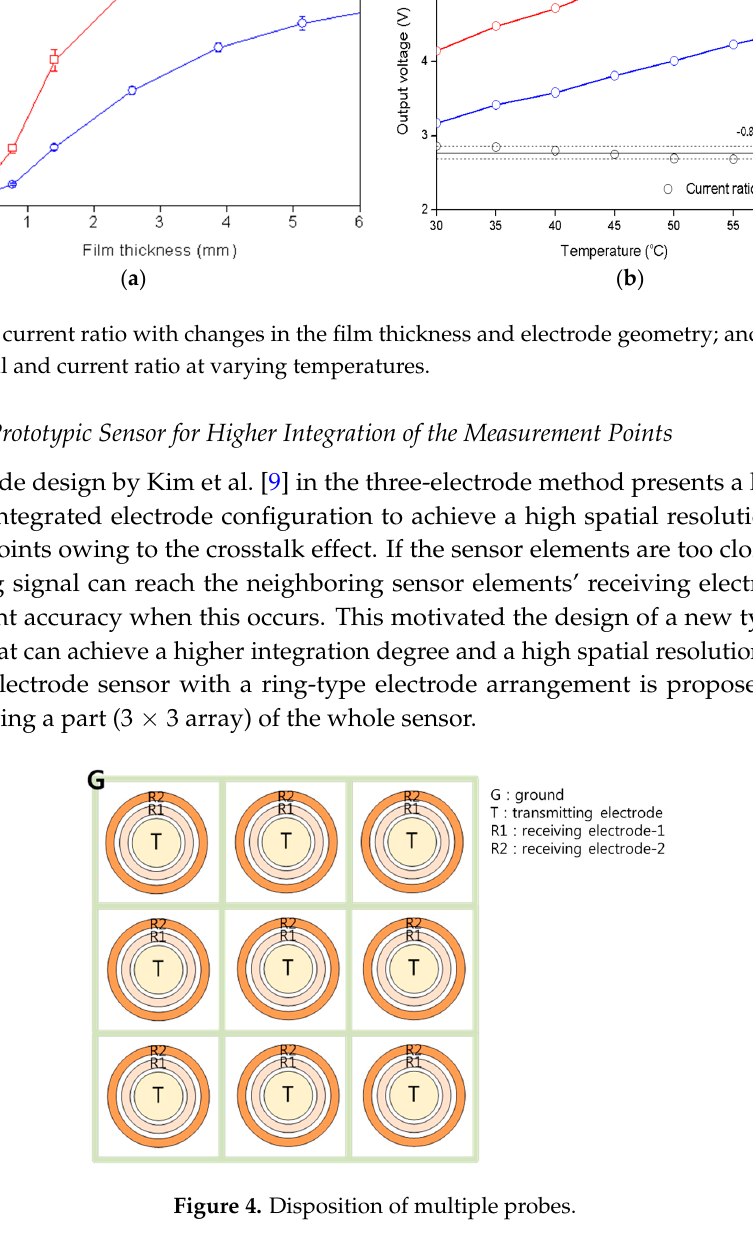
Figure 4. Disposition of multiple probes.